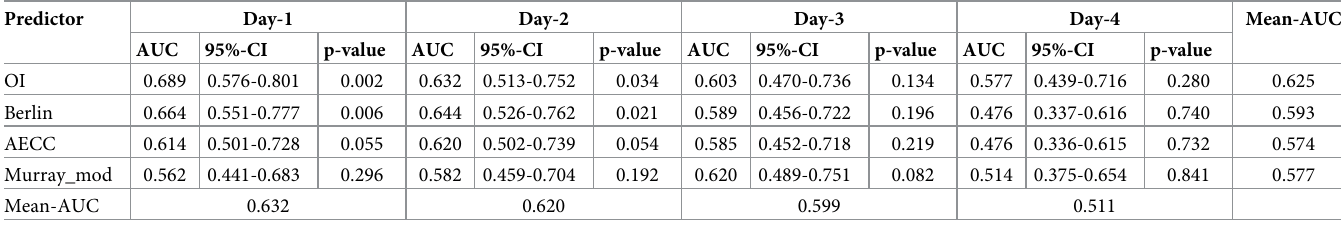
Table 3. Prediction of 28-days-mortality by OI, Berlin-, AECC-definition and modified Murray-score: All patients. Predictor